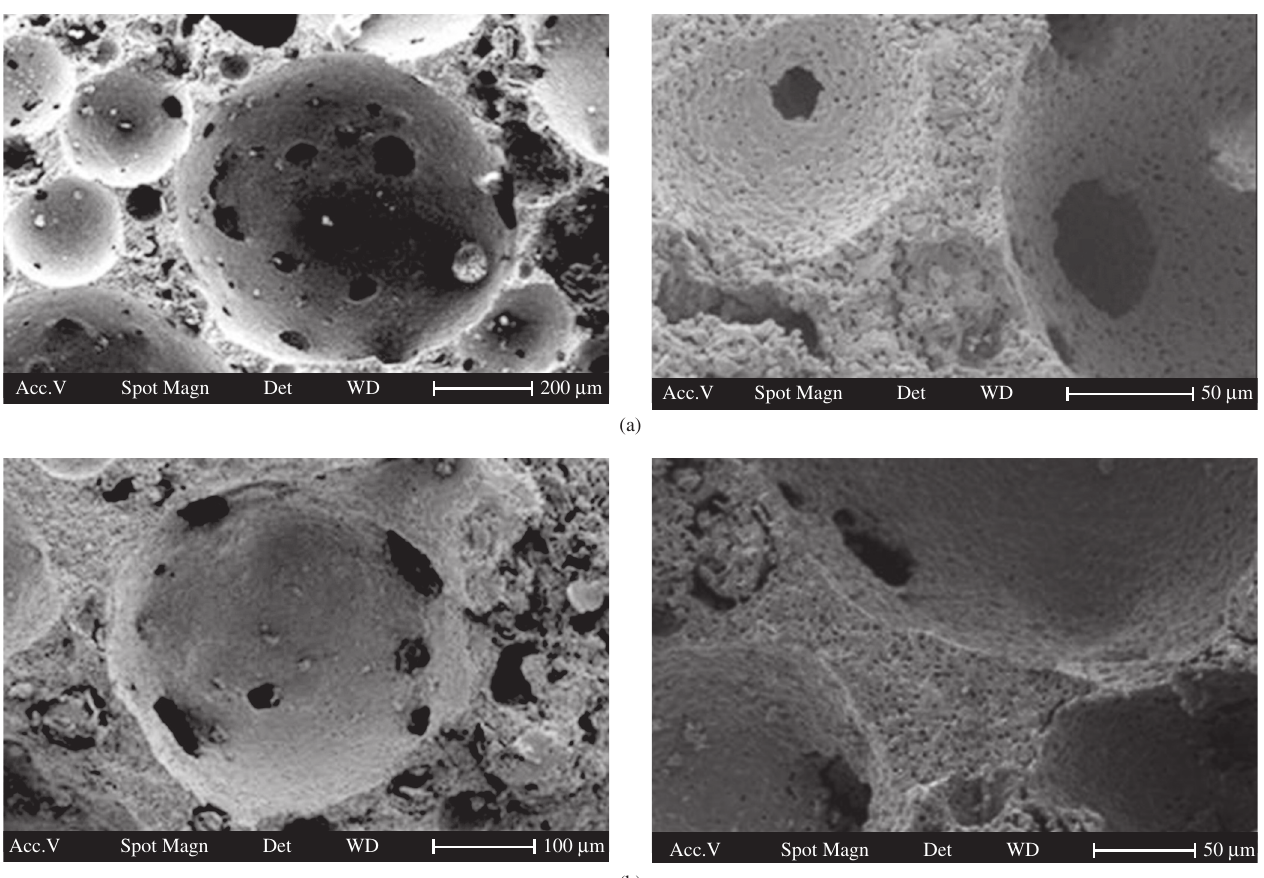
Figure 6. Micrographs of fractured surfaces of specimens obtained by the direct consolidation process using albumin. a) β -TCP 6% albumin; and b) β -TCP 5%